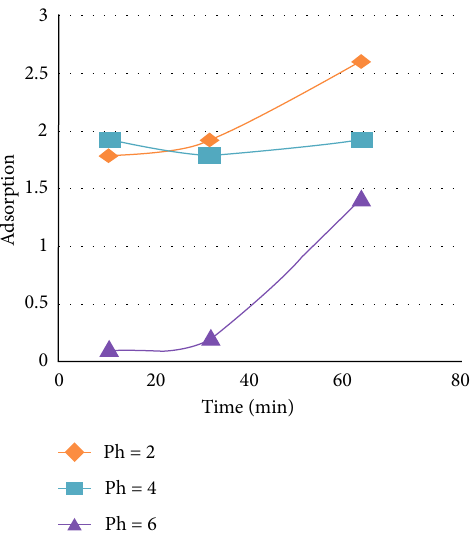
Figure 6: The relationship of time to adsorption for di ff erent values of the acidity function at a concentration of